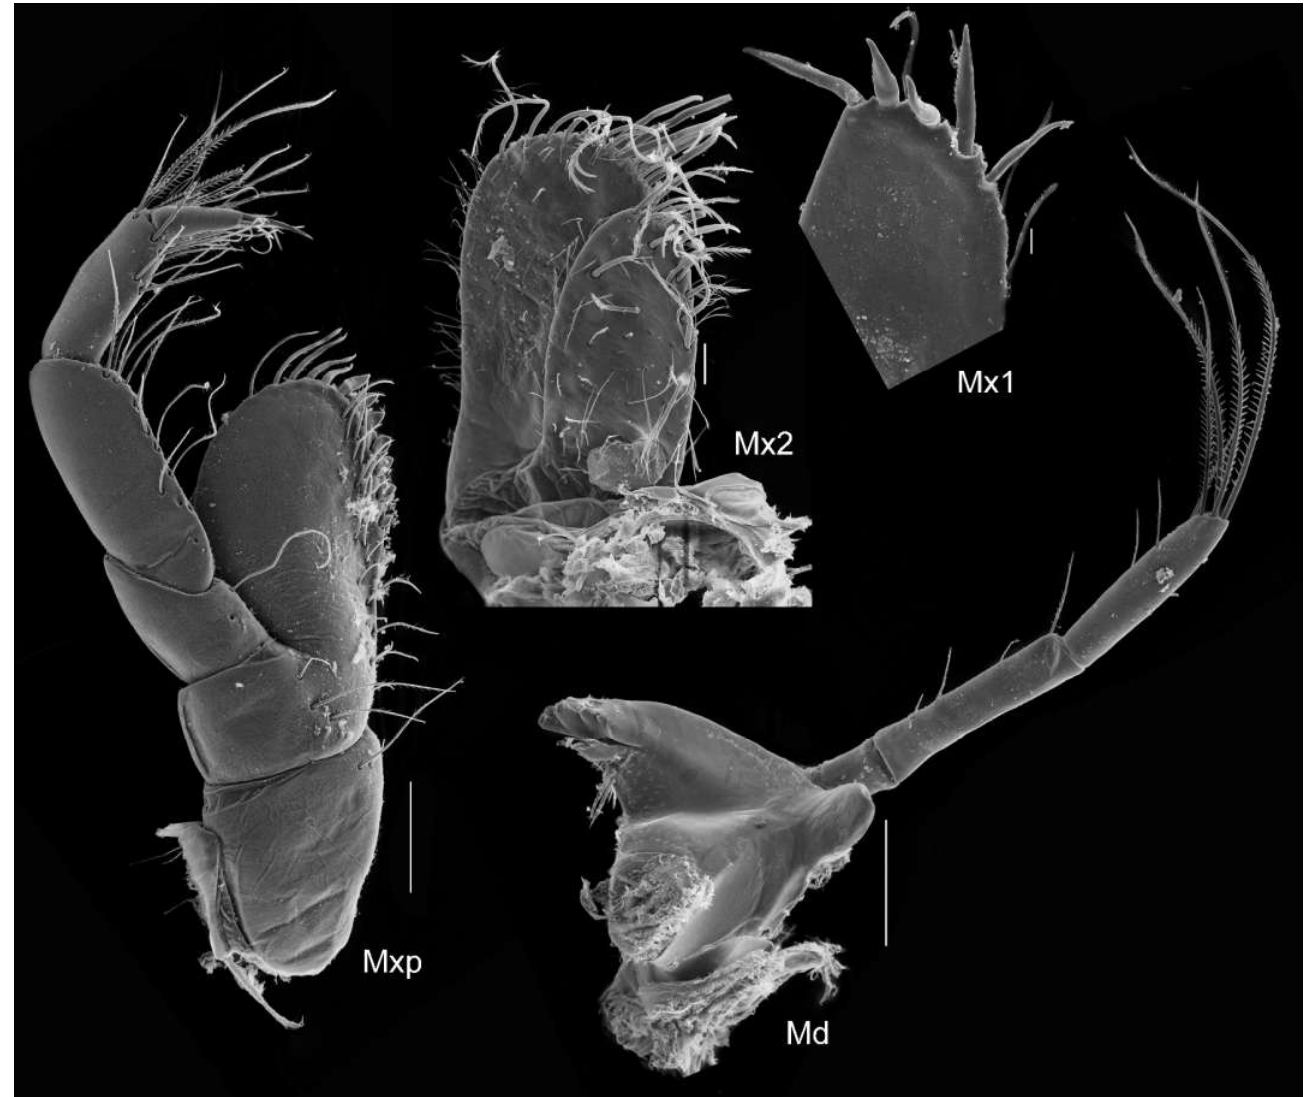
Figure 17. Unciola icelandica sp. nov. SEM image, paratype female, 6 mm, ZMHK-56725, South Island, Iceland Basin, 1921 m. Scales: mandible and maxilliped 100 µm, maxilla 2 20 µm, tip of maxilla 1–10 µm.